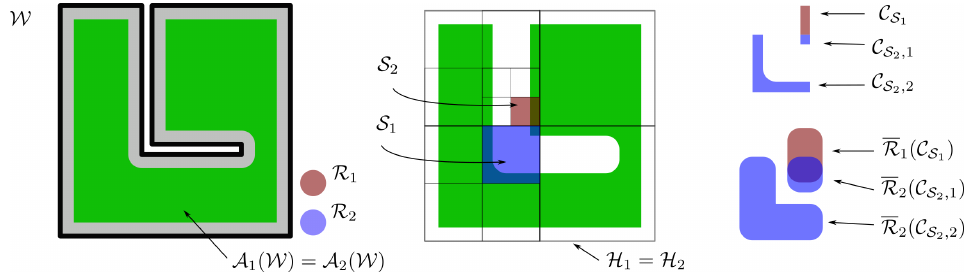
Figure 3. Example of a hierarchical configuration space decomposition for a system of two identical robots. The green area corresponds to the configuration space A i ( W ) of each robot. For the sake of simplicity, we assume H 1 = H 2 . The workspace slice S 1 corresponding to robot 1 consists of a single simple cell ( C S ) whereas slice S 2 corresponding to robot 2 consists of two cells ( C S 1 compound cell ( C S , C S ) is labeled as mixed because R 1 and R 2 may intersect when p 1 ∈ C S 2 ,1 1 p 2 ∈ C S because R 1 ( C S ) ∩ R 2 ( C S ) (cid:54) = ∅ , whereas ( C S , C S ) is marked as 2 ,2 2 ,1 2 ,2 1 1